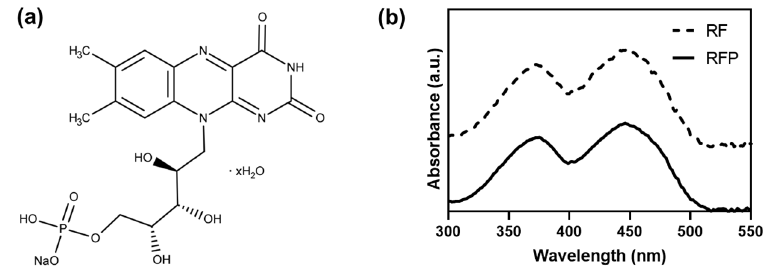
Figure 1. ( a ) Chemical structure of riboflavin phosphate. ( b ) Absorbance spectra of riboflavin (RF) and riboflavin phosphate (RFP) aqueous solution.